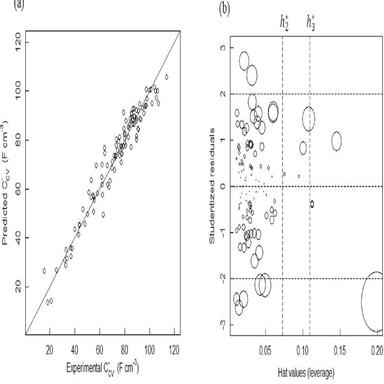
Experimental values vs. predicted cathodic volumetric capacitance (a) and model diagnostic plot (b) corresponding to Eq..